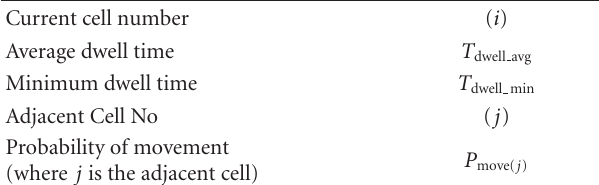
Table 2: Information of cell for each